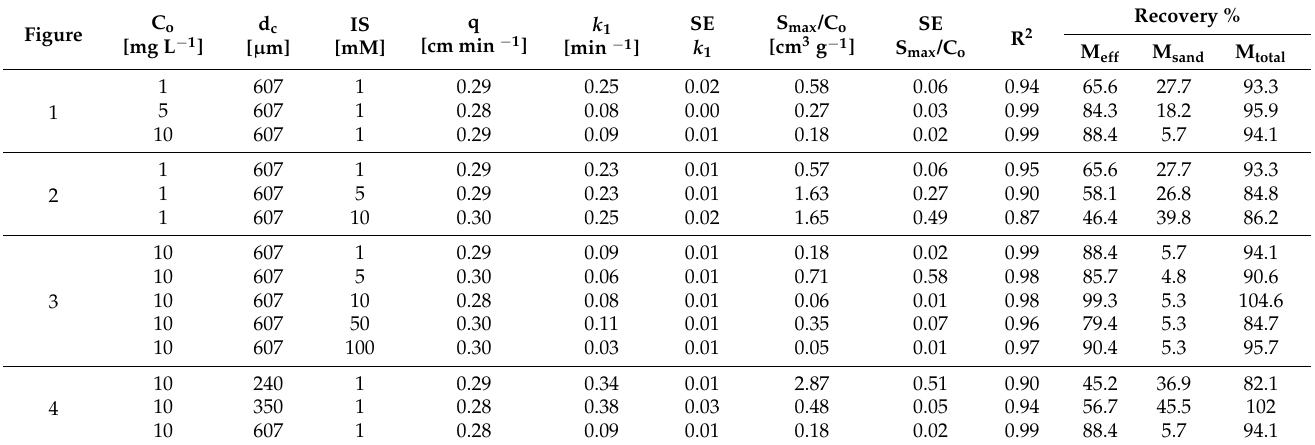
Table 2. Experimental and model parameters and column experiments’ mass